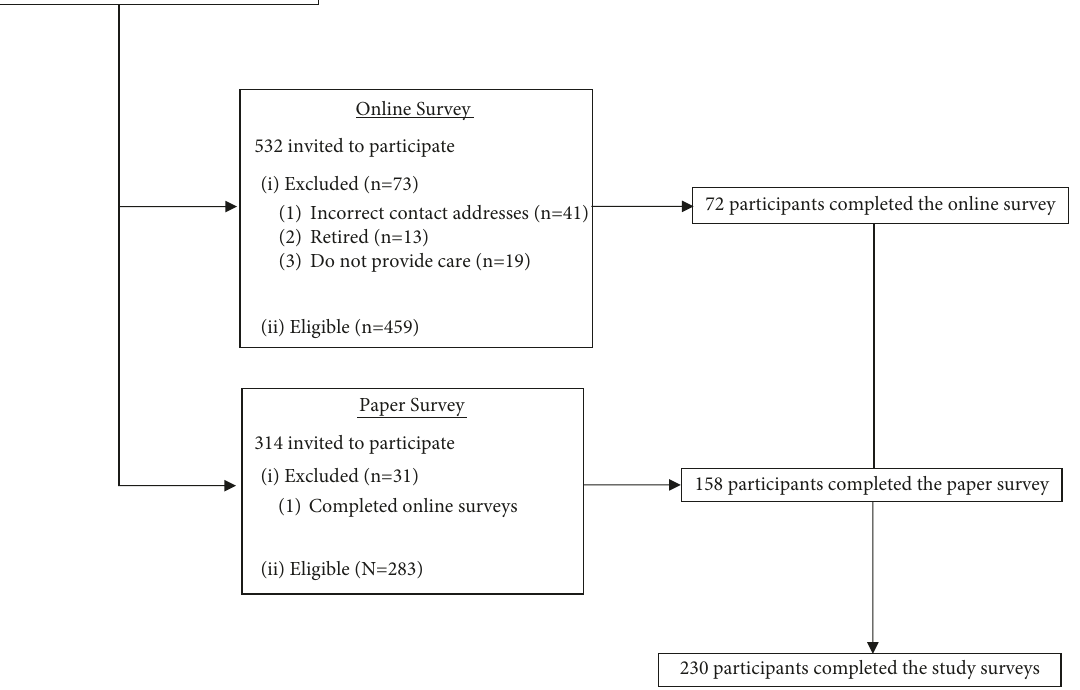
Figure 1: Flow chart of survey study participants.